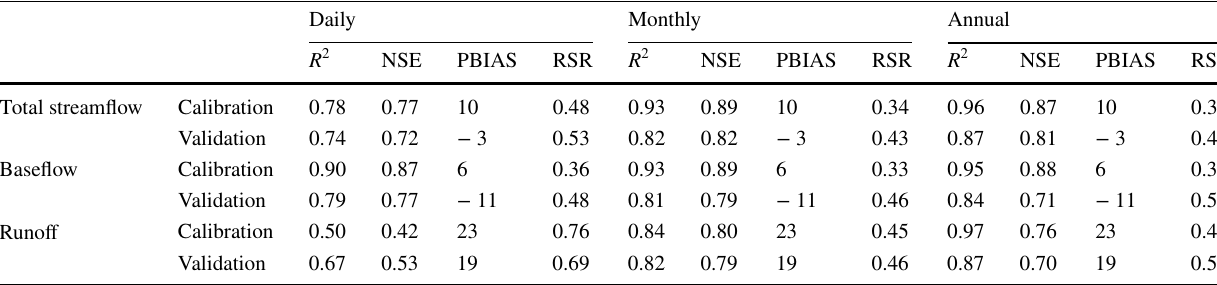
Table 2 Calibration of MYS streamflow with validation